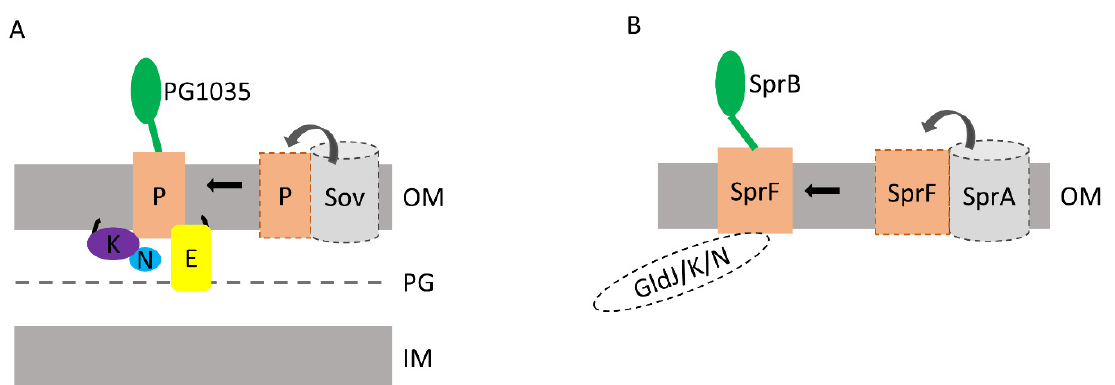
Figure 7. The proposed organisation of PorE-PorP-PG1035 and SprF-SprB complexes. ( A ) PorE (E) is localised in the periplasm tethered to the OM via its lipid moieties (lipid shown as black line). PorE interacts with the OM 14-stranded β -barrel protein, PorP (P). PorP associates with PG1035 on the cell surface via the CTD of PG1035, shown as a green line. PorP also associates with the PorK/N (K/N) ring via its interaction with PorK (K) lipoprotein. ( B ) The gliding motility protein, SprB, associates with the OM 14-stranded β -barrel protein, SprF, on the cell surface. SprF may also associate with the Gld/J/K/N protein track. Based on our results, we predict that PorP and PorP-like proteins such as SprF associate with the Sov/SprA translocon to collect their respective type B CTD proteins. OM: outer membrane; PG: peptidoglycan; IM: inner membrane.